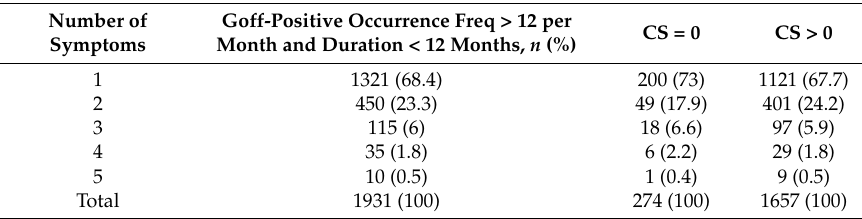
Table 8. Occurrence of multiple